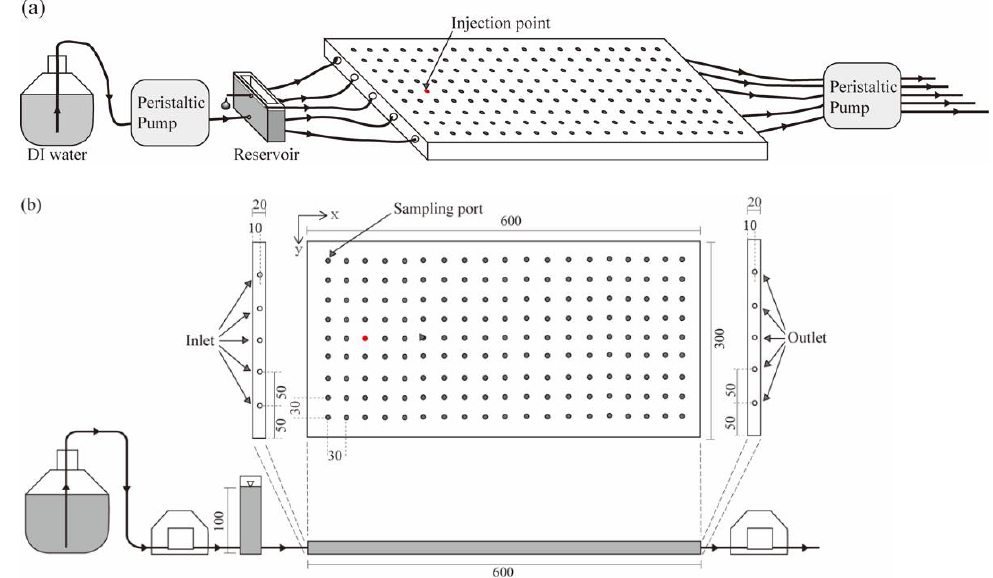
Figure 1. ( a ) Laboratory system for two-dimensional solute transport experiments; ( b ) layout of aquifer model (top view and front